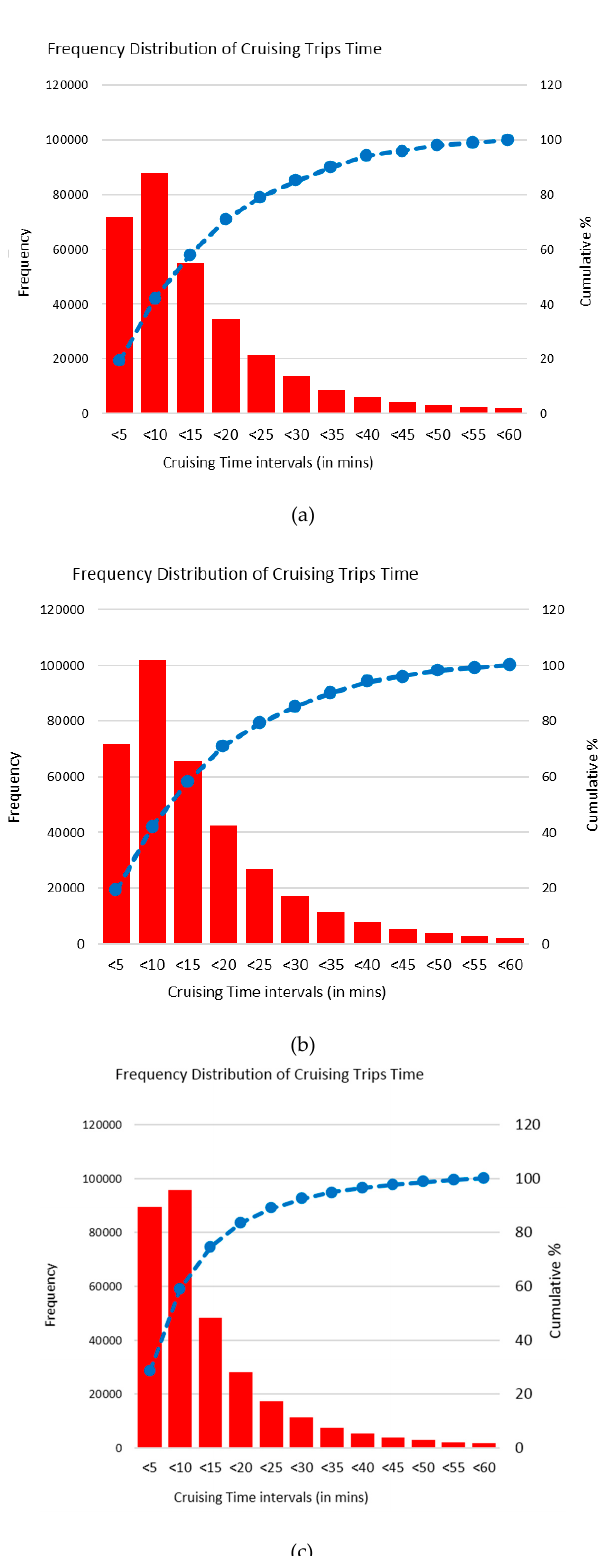
Figure 5. Frequency distribution of the cruising trip time of low ( a ), moderate ( b ) and high ( c ) profitability drivers. ( c ) profitability